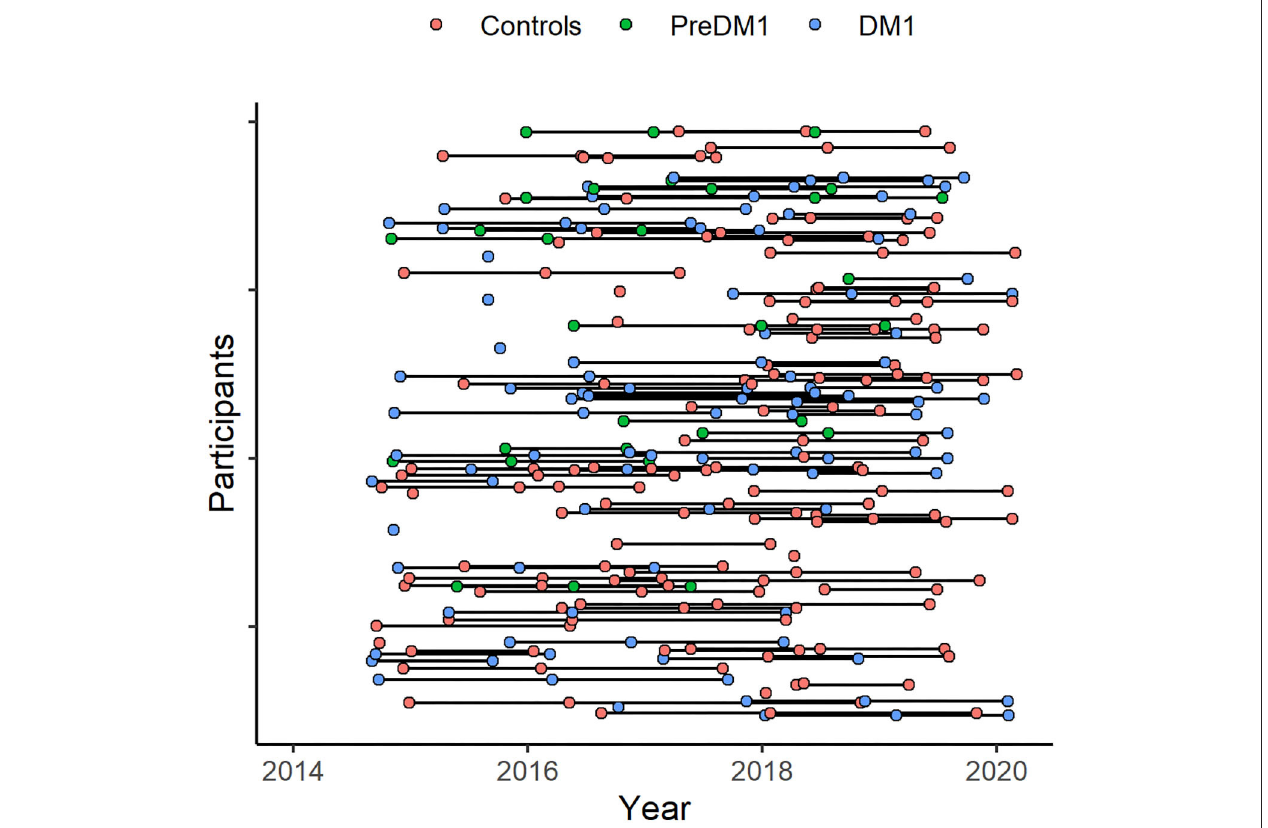
FIGURE 1 | Participant assessment over the study period. Assessments took place between 2014 and 2020 ( x -axis). Participants ( y -axis) were assessed on multiple occasions, approximately 1 year apart. The timing of baseline assessments varied across participants and not everyone completed all planned